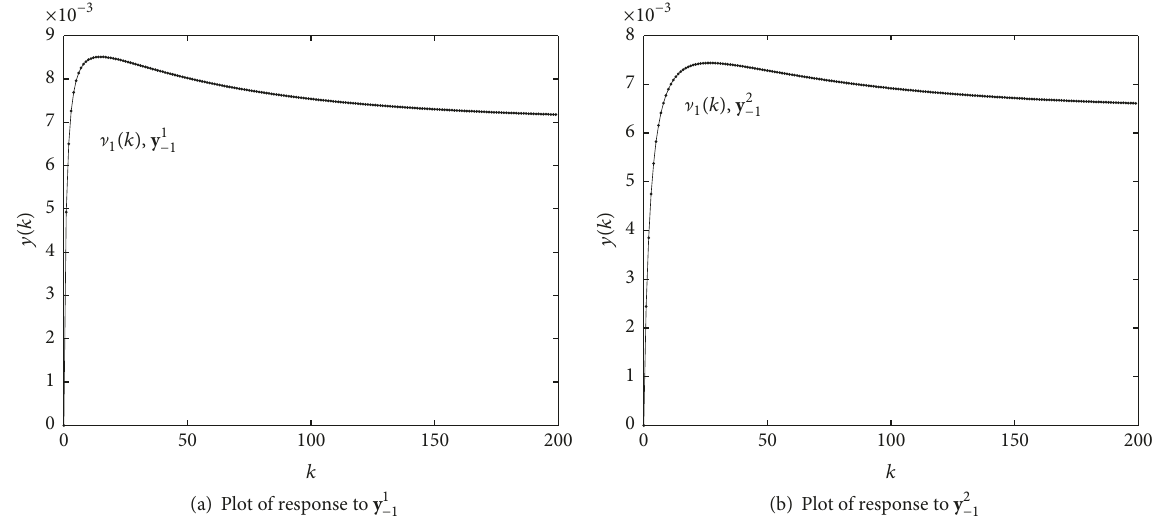
Figure 7: The VFOI homogenous responses to y 1 −1 and y 2 −1 with 𝑏 0 = 0.001, 𝑘 0 = 0 in formula (34) and the order ] 1 (𝑘) = 1 − 𝑒 −0.01𝑘